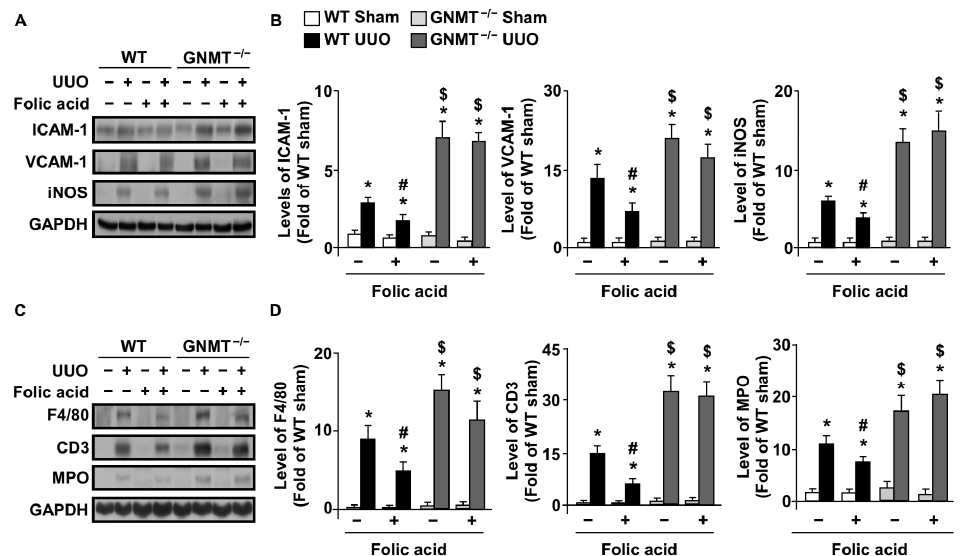
Figure 5. Effect of folic acid on UUO-induced renal inflammation and leukocyte infiltration in WT and GNMT − / − mice. ( A , B ) Tissue extracts from kidneys were analyzed via immunoblotting with antibodies against the adhesion molecules ICAM-1 and VCAM-1, as well as inflammatory markers of iNOS. ( C , D ) Tissue extracts from kidneys were also analyzed via immunoblotting with antibodies against leukocyte markers, including F4/80, CD3, and MPO. * p < 0.05 versus the sham group, # p < 0.05 versus non-folic acid-treated mice, $ p < 0.05 versus WT mice.